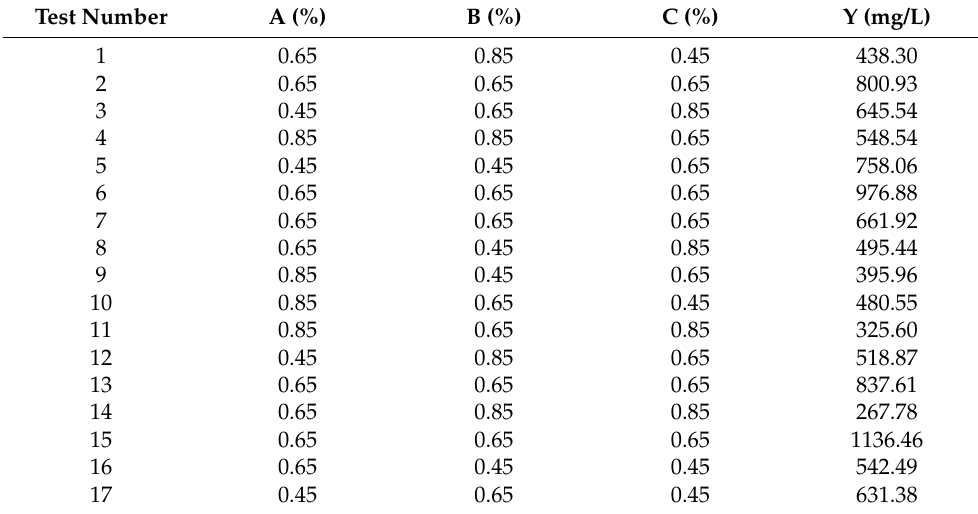
Table 4. Experimental design of three independent variables and actual values of GA4 production using BBD.